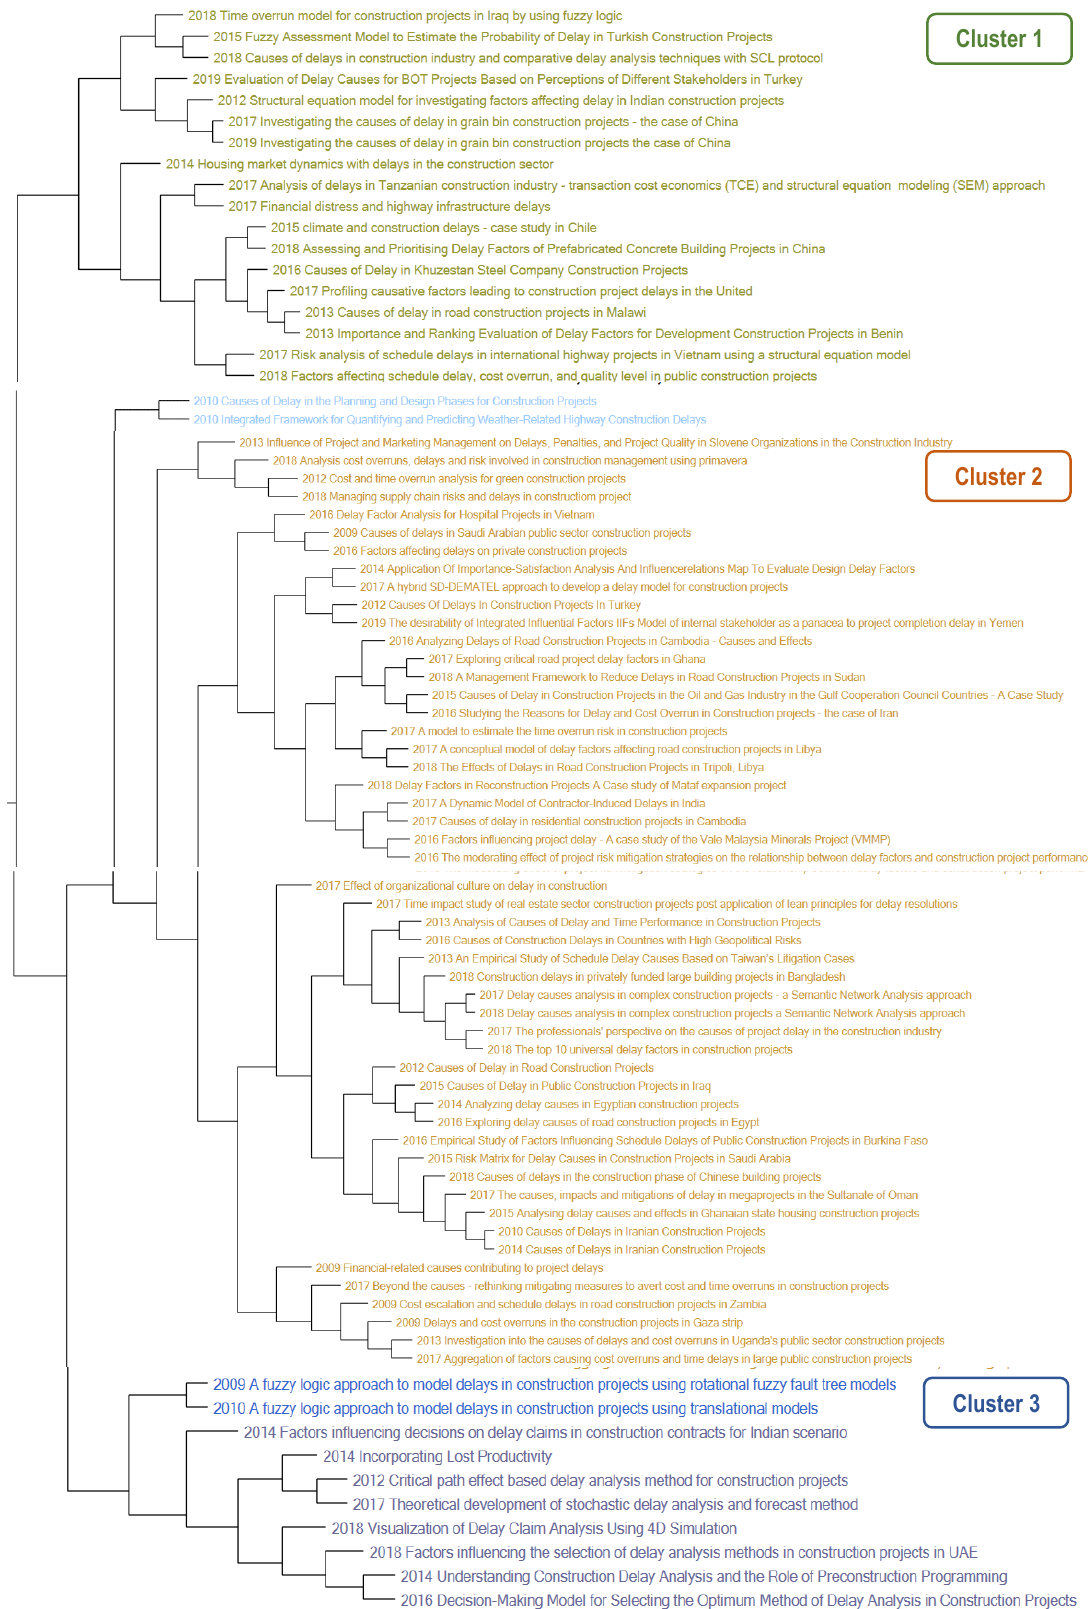
Figure 6. Five branches of papers in the DEC, including three clusters of the main relevant articles for the content analysis.